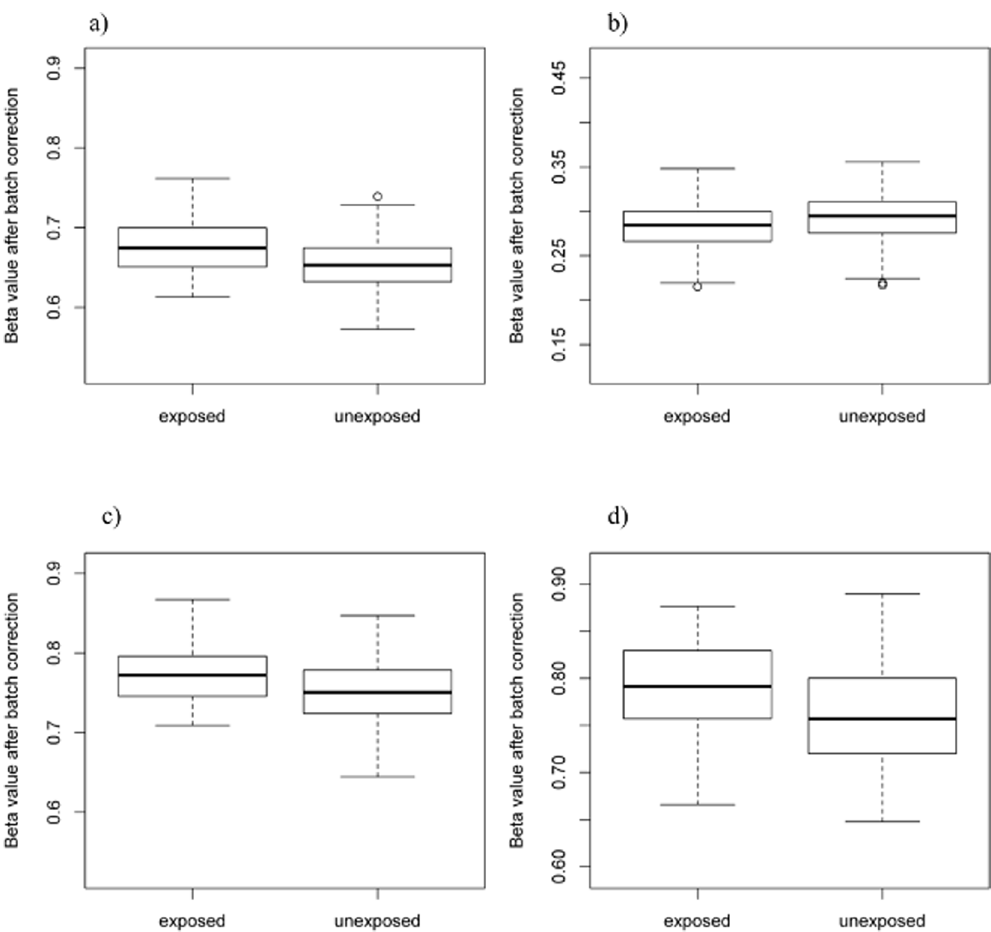
Figure 1. Boxplots showing the distribution of % CpG methylation after normalization and batch correction using COMBAT by IUS exposure for A) C11orf52 (cg05697249), B) XPNPEP1 (cg09352789), C) FRMD4A (cg25464840), and D) PPEF2 (cg14724265) in 526 Asthma BRIDGE samples.